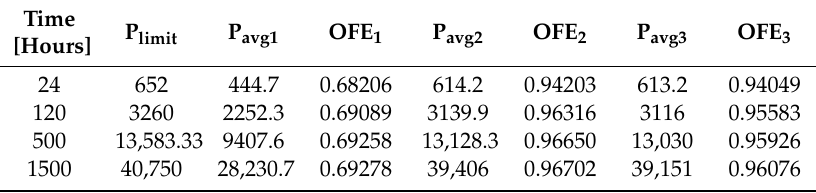
Table 4. The Overall Factory E ff ectiveness (OFE) metrics for model of 6 AGVs without failures OFE 2 and with failures OFE 3 and OFE 1 from the previous experiment.